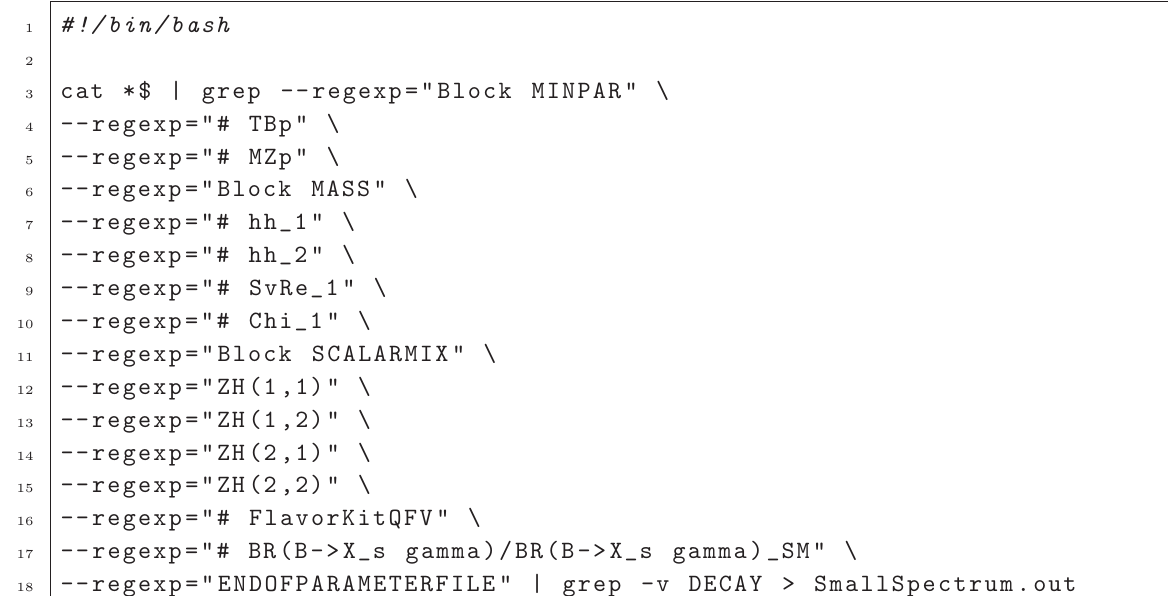
Figure 12: The two lightest CP even sneutrino masses (top left), the lightest CP even and odd sneutrino mass (top right), the lightest CP even sneutrino and the lightest neutralino mass (bottom left), and the decomposition of the lightest neutralino (bottom right). Plots are produced with SSP using EP1 and a variation of tan 𝛽 󸀠 .